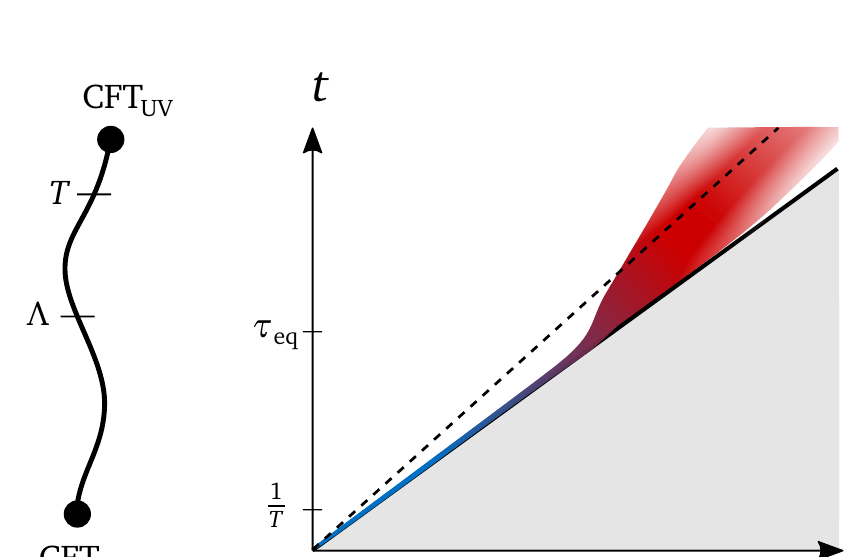
Figure 1: Left: 2d QFT obtained from a UV CFT and a relevant deformation with scale Λ . Right: Sketch of a correlator (e.g., 〈 T The solid line is the lightcone x = t . The correlator is well described by the CFT expression at early times t (cid:174) τ where a sound front emerges along the dashed line x = c